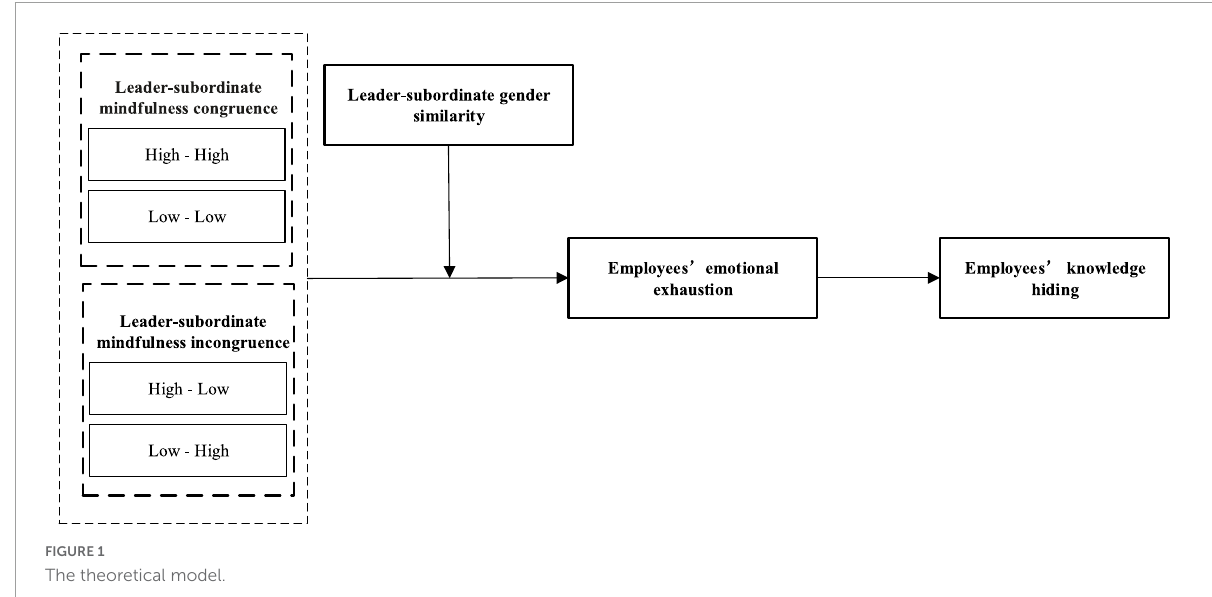
FIGURE1 The theoretical